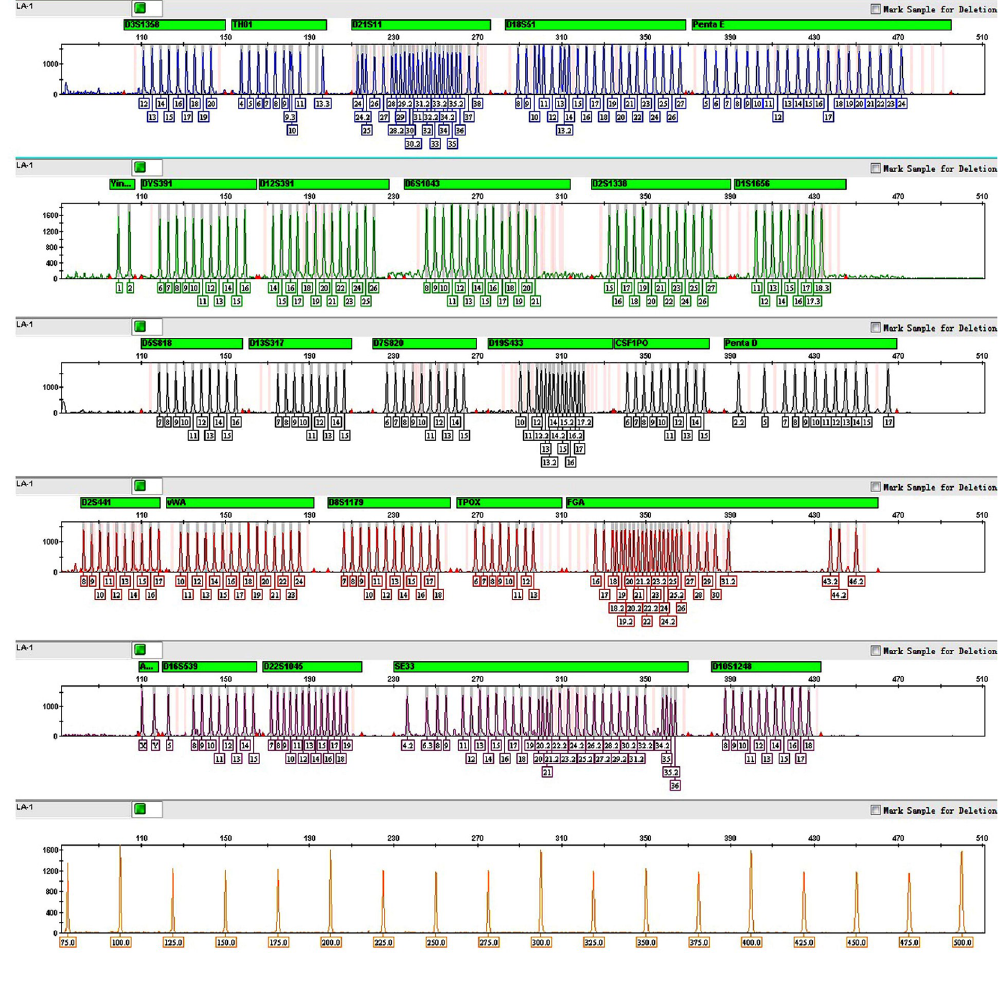
Figure 1. Electropherogram of allelic ladders and internal size standard in the SureID PanGlobal system. The five dye panels for allelic ladders correspond to (from top to bottom) 6FAM (blue), HEX (green), TAMRA (yellow), ROX (red),and ALEXA594(purple) dye-labeled peaks. The sixth panel reserved for internal size standard labels an orange SIZE500 dye. The genotype is shown with the allele number displayed underneath each peak. One microliter each of allelic ladders and internal size standard were simultaneously analyzed on an Applied Biosystems 3500 XL Genetic Analyzer with a 1.2 kV, 15 s